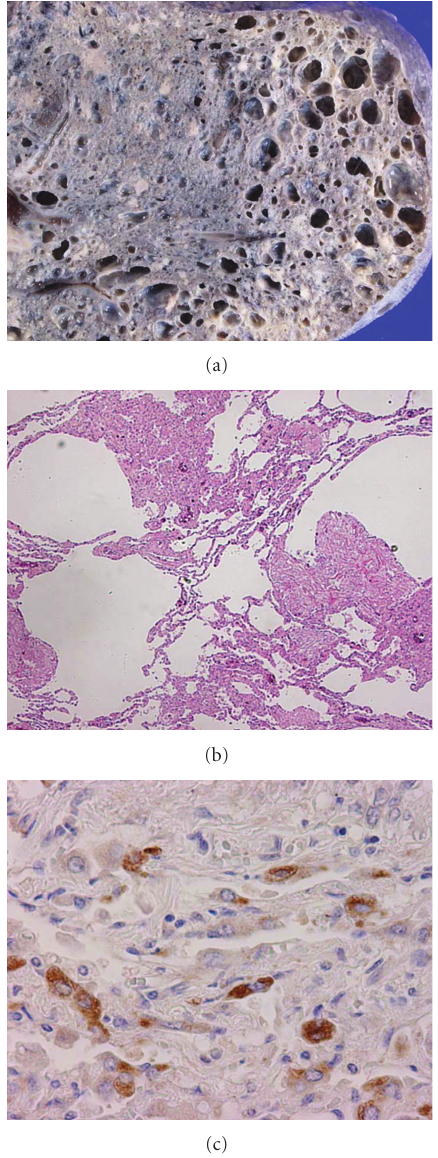
Figure 1: Papillary serous carcinoma of peritoneum (PSCP) on hysterectomy. Cancer cells proliferate and infiltrate in a papillary architecture to the abdominal cavity (a). Epithelial membrane antigen (EMA) is positive (b), but carcinoembryonic antigen (CEA) is negative (c).